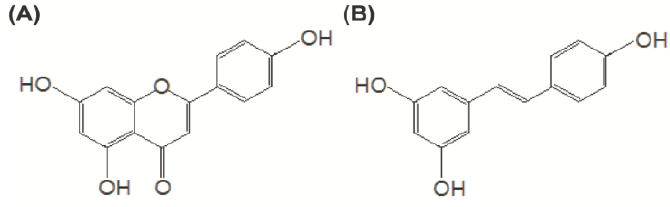
Figure 1. Structures of apigenin ( A ) and resveratrol ( B ).